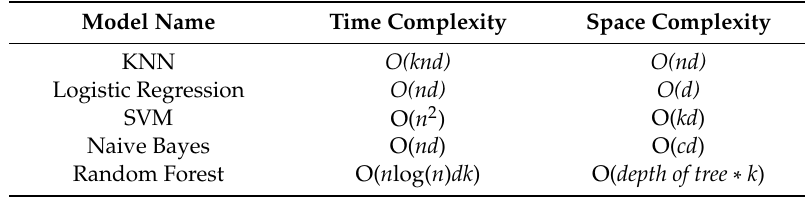
Table 26. Time and Space Complexities of Machine Learning